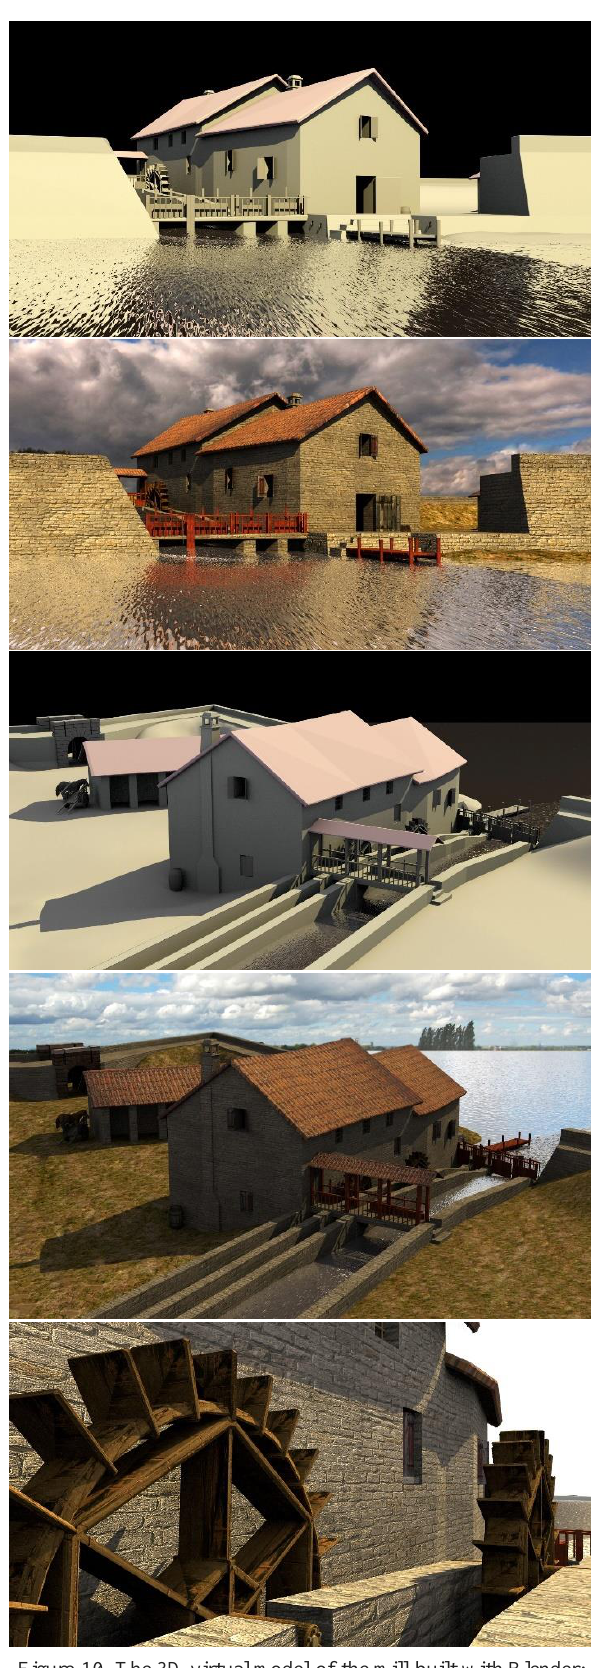
Figure 10. The 3D virtual model of the mill built with Blender: images of the structure without and with textures; general and particulars